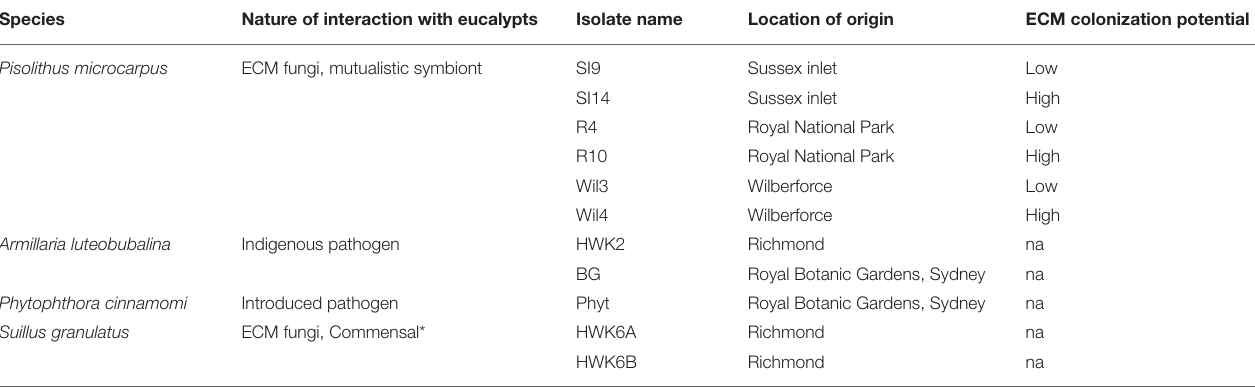
TABLE 1 | Table summarized the species and location of origin within NSW, Australia of the fungi/oomycete isolates used in this study, and the colonization potential of the ECM fungal strains.